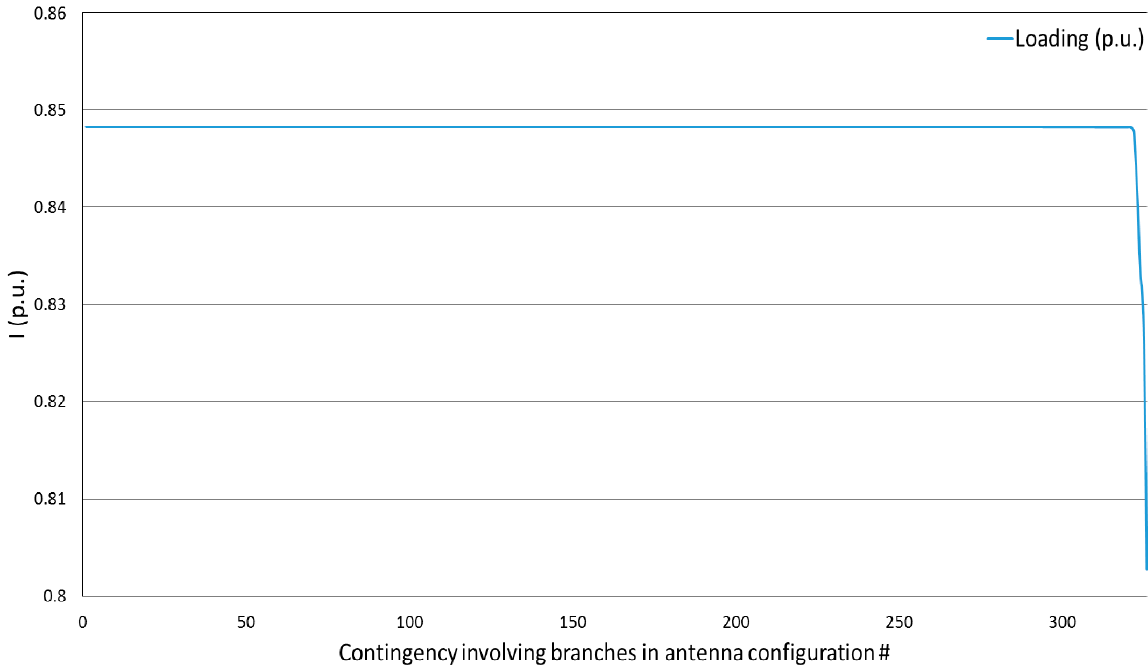
Figure 10. Maximum loadings (in p.u. of the branch capacity) due to contingencies involving branches in antenna.